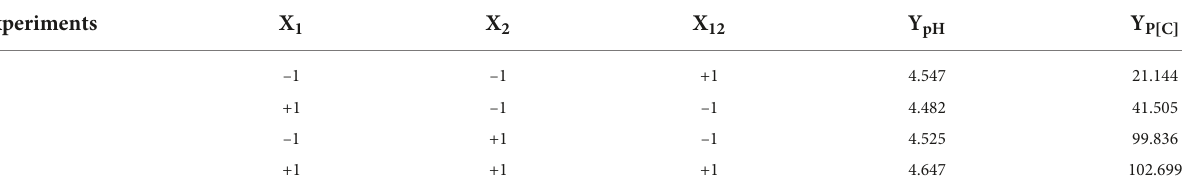
TABLE 7 Experimental design results done after P solubilization by isolate